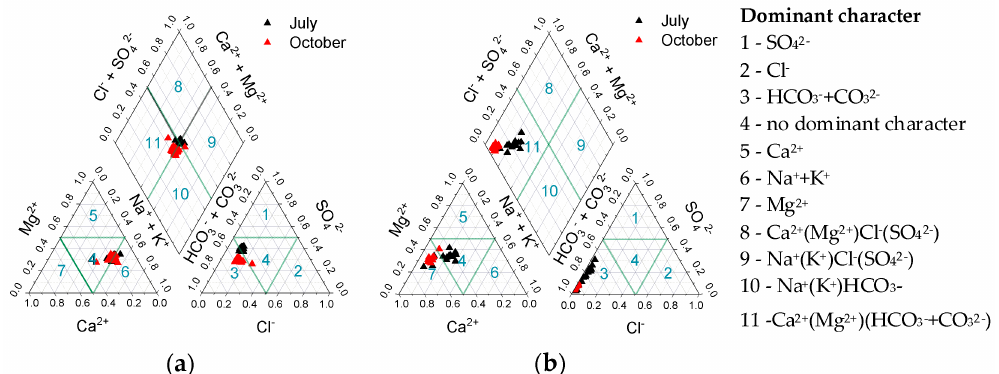
Water 2021 , 13 , x FOR PEER REVIEW Figure 3. Piper diagrams corresponding to water ( a ) and sediment ( b ) samples collected from Podu Iloaiei Dam Lake.